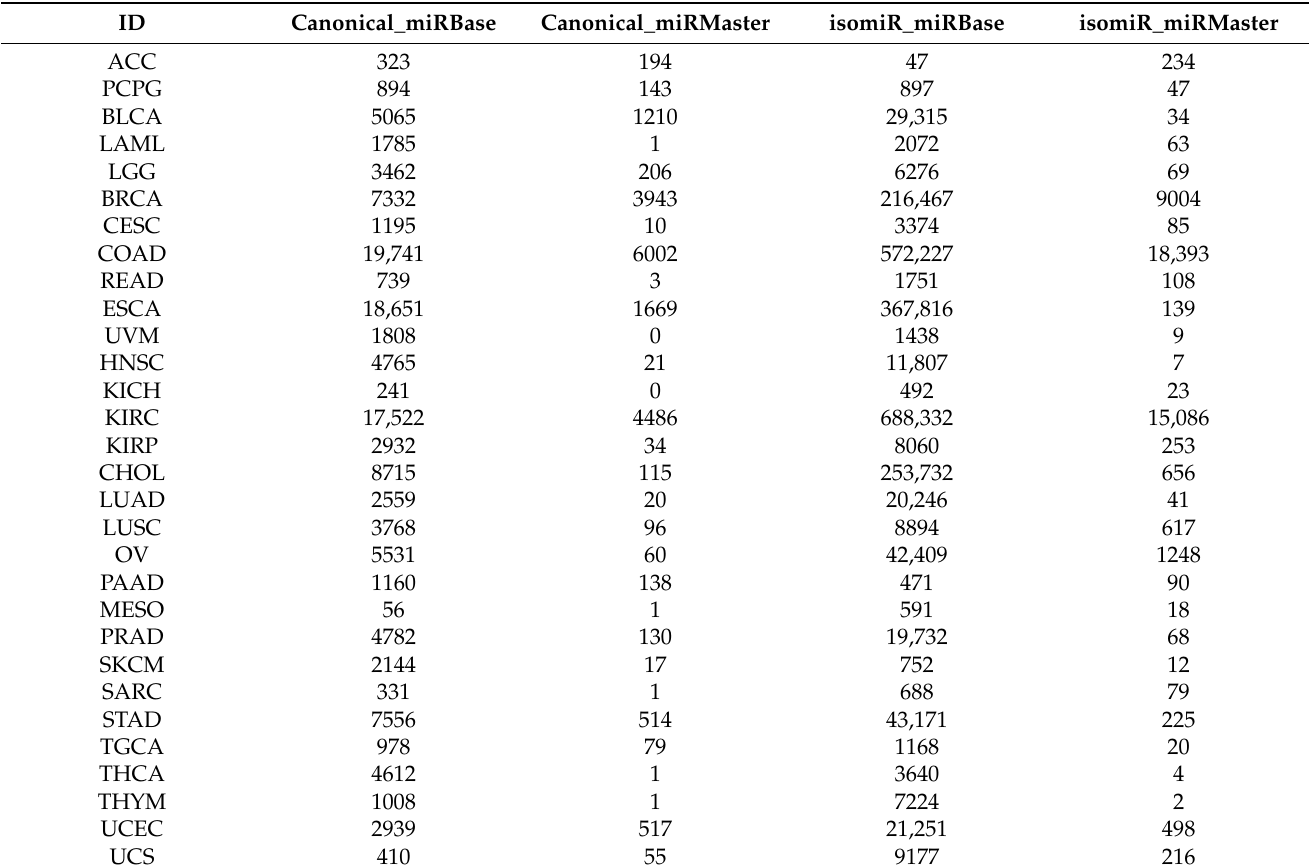
Table 2. The number of identified miR and isomiR-eQTL in each cancer type from TCGA tumour tis- sue data. The miR and isomiR-eQTL were identified by linear regression using MatrixEQTL